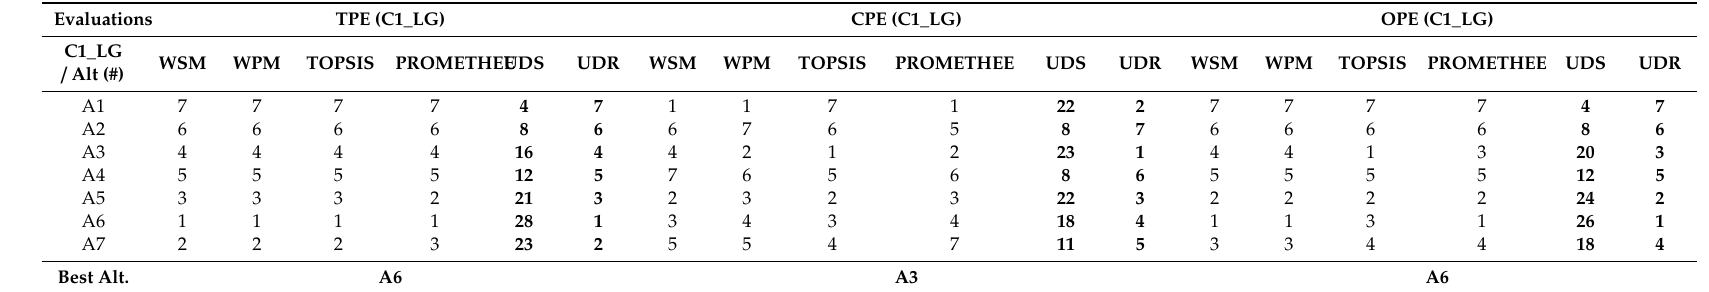
Table 14. Order of the ranks across TPE, CPE, and OPE in C1_LG for 33-bus MDN.